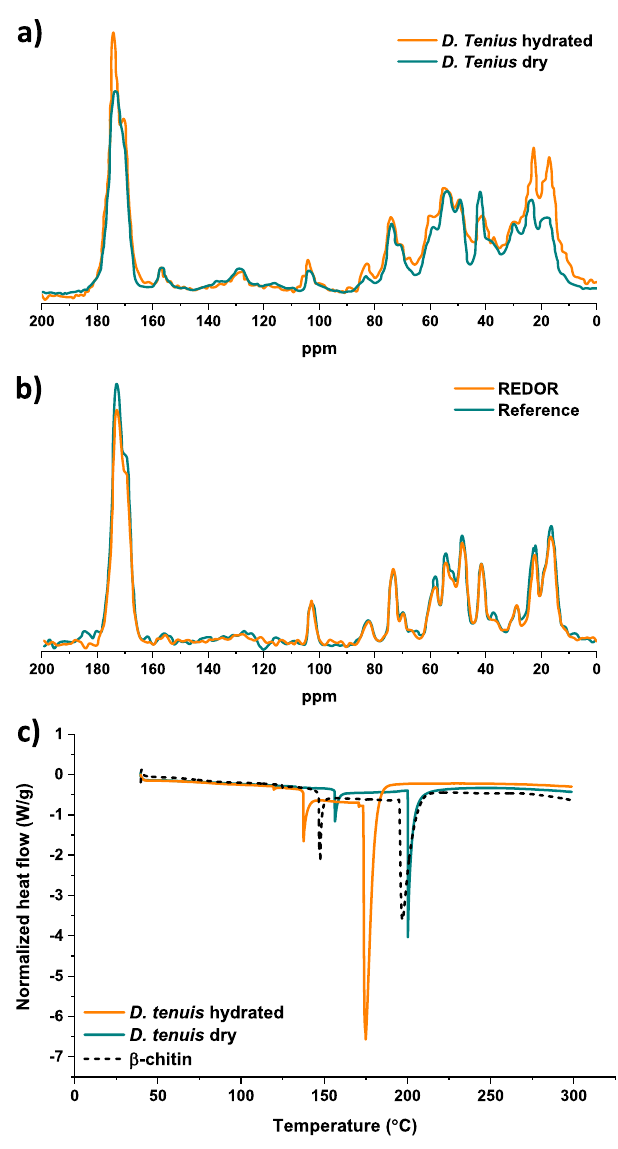
Fig. 5 Solid-state nuclear magnetic resonance spectroscopy and differential scanning calorimetry of D. tenuis brachiopod shell samples. a 13 C Cross-polarization magic angle spinning (CP MAS) NMR spectra of an atmospherically dry and hydrated shell. b Rotational-echo double resonance (REDOR) NMR on an atmospherically dry shell, cyan: reference spectrum; orange: REDOR dephasing spectrum. c Differential scanning calorimetry measurements of an atmospherically dry and hydrated specimen and of β -chitin extracted from a brachiopod